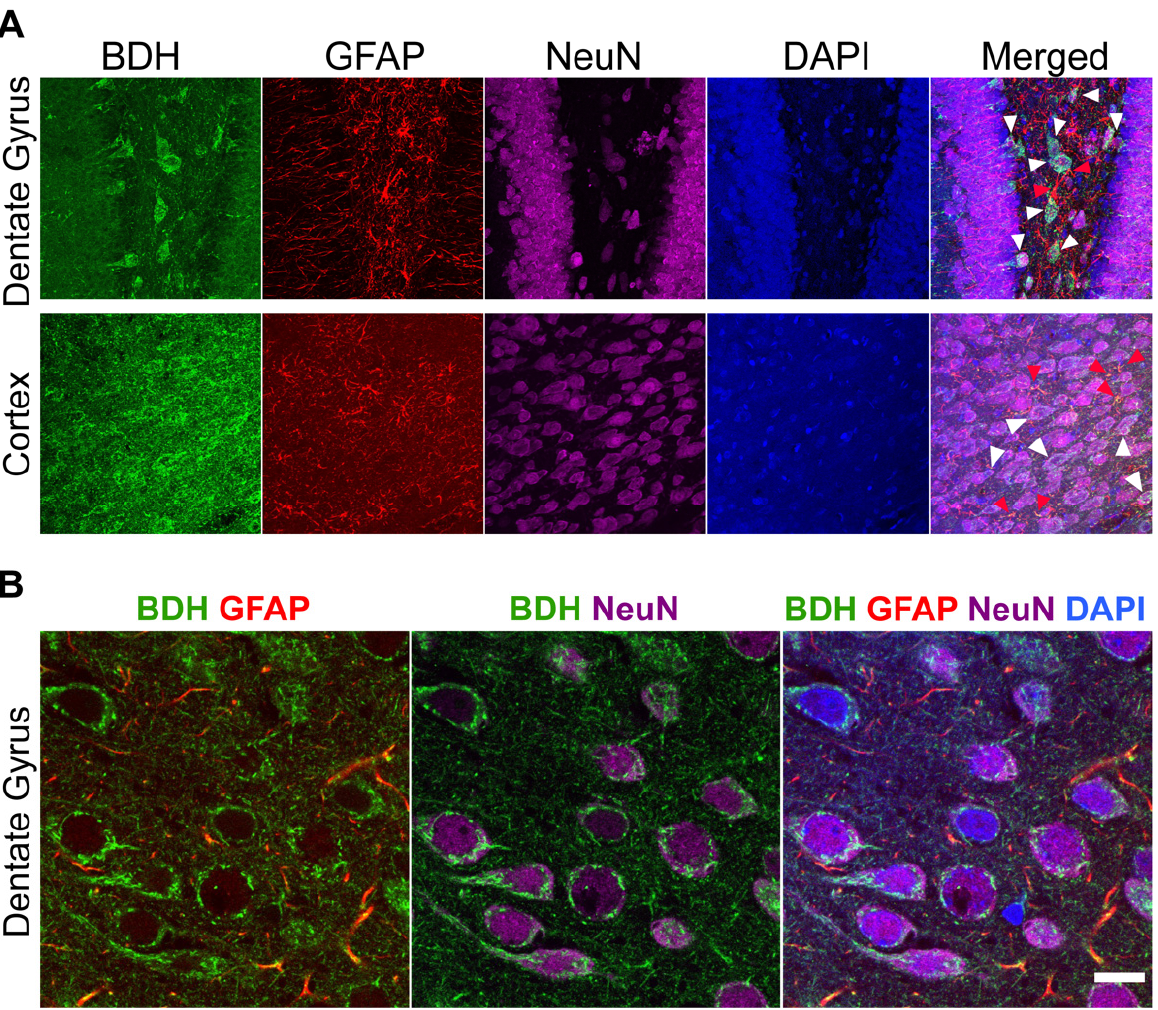
Figure 2. β -hydroxybutyrate dehydrogenase (BDH) labeling is present in both neurons and astrocytes in 21–22-day-old rat brain. ( A ). Representative fluorescence image of BDH staining in brain depicting expression of BDH in both astrocytes (GFAP) and neurons (NeuN). Examples of co-localization of BDH with GFAP are indicated with red arrows and BDH with NeuN with white arrows in the dentate gyrus and cortex. ( B ). High magnification (100×) in the dentate gyrus further illustrates co-localization. Scale bar = 10 µm .